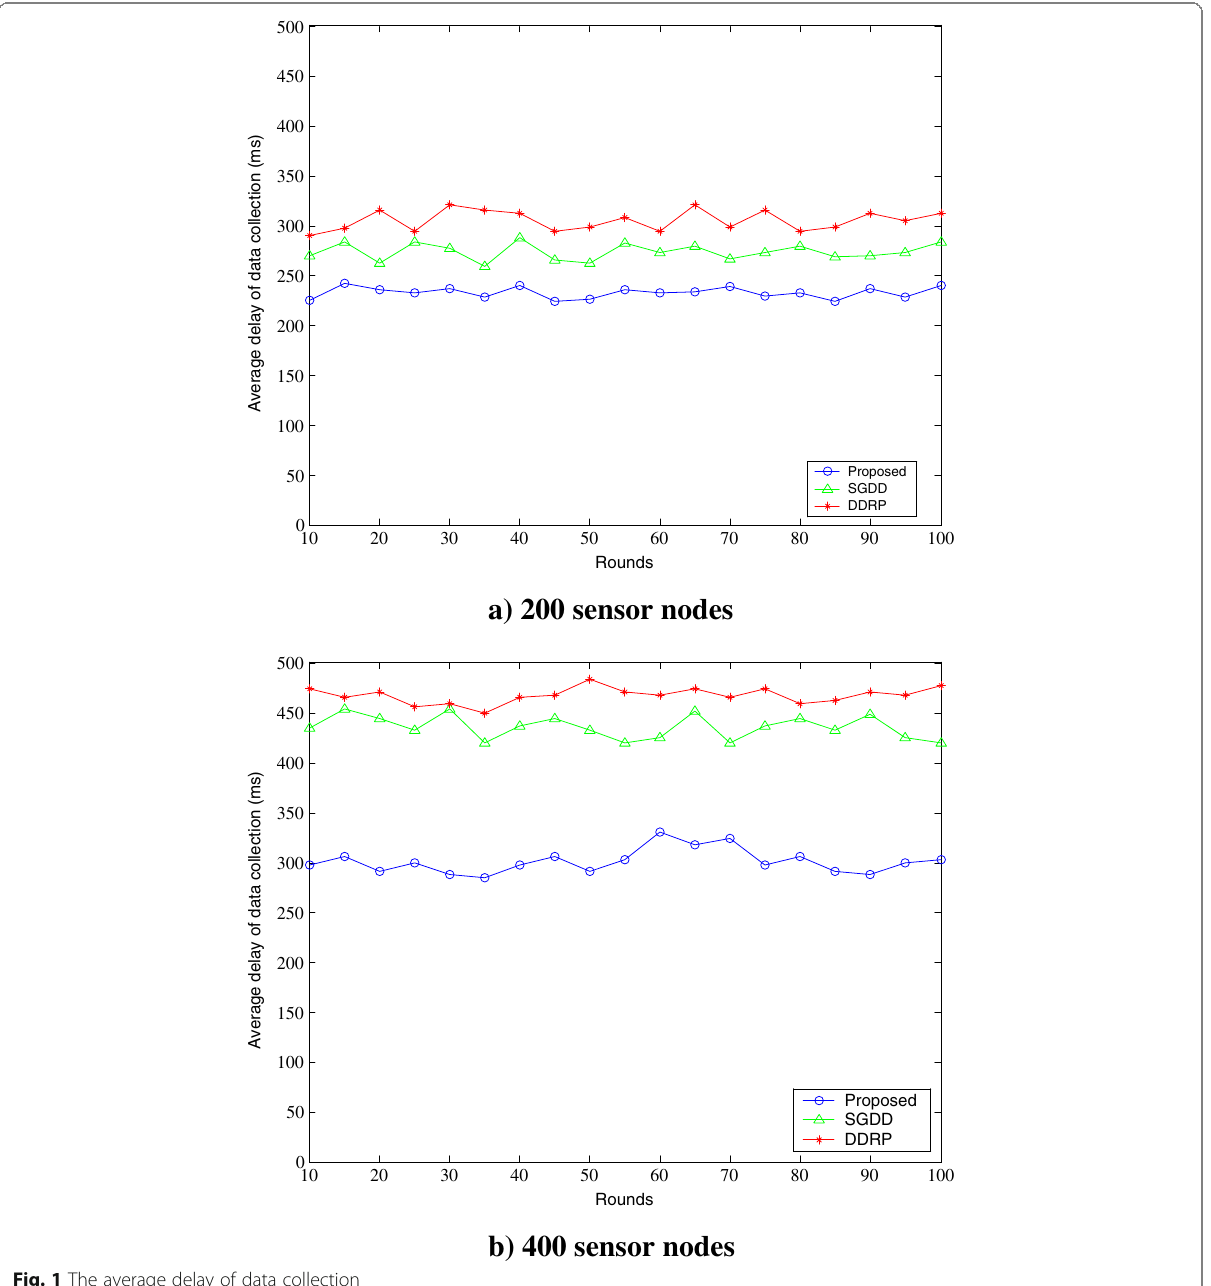
Fig. 1 The average delay of data